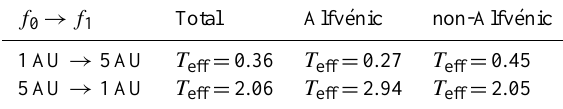
Table 1. The effective temperature T eff as obtained by numerically solving Eq.